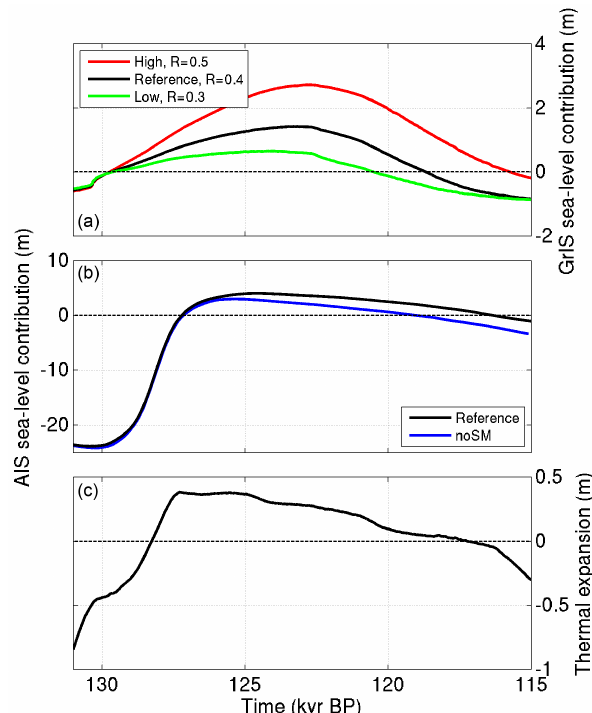
Figure 11. Sea-level contribution from the Greenland ice sheet for the reference run (black) and two sensitivity experiments with higher (red) and lower (green) temperature scaling (a) . Sea-level contribution from the Antarctic ice sheet from the reference run (black) and from a sensitivity experiment without sub-shelf melting (blue) (b) . Sea-level contribution from oceanic thermal expansion from the reference run (c)